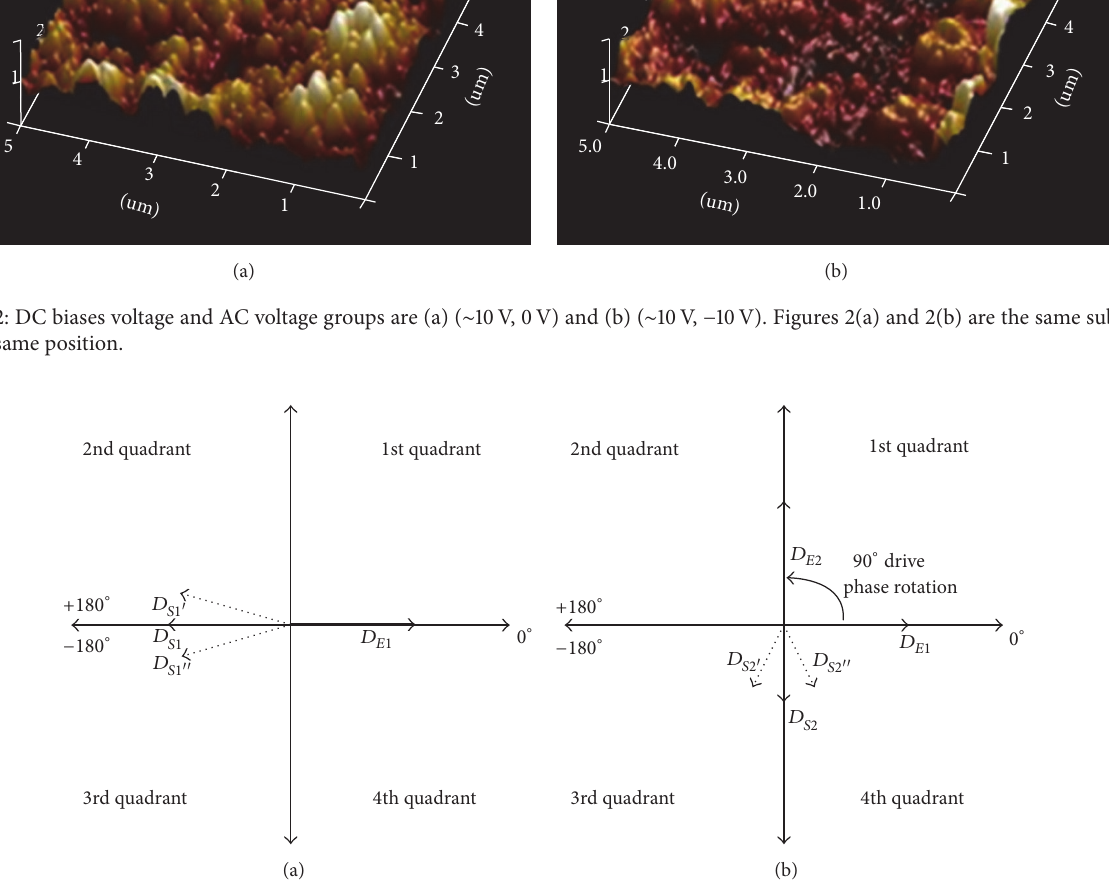
Figure 3: Vector diagram of 𝐸 field and sample oscillation vectors for (a) 0 ∘ and (b) 90 ∘ drive phase